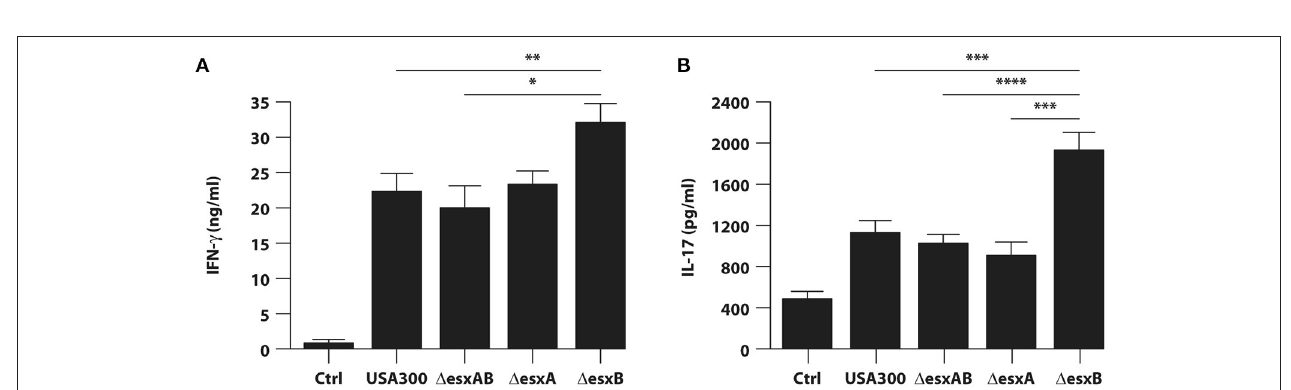
FIGURE 6 | Expansion of IFN- γ or IL-17 producing T cells by cytokine milieu released from DC infected with wild type USA300 and esx mutants. Total CD4 + T cells were stimulated with anti-CD3/CD28 magnetic beads in presence of supernatants derived from DC cultures untreated or infected for 24 h with wild type USA300 or esx mutants. IFN- γ (A) and IL-17 (B) production was evaluated in harvested supernatants by ELISA. The results shown represent means ± SEM of 4 independent experiments. Significance was calculated by Student’s t- test. * P = 0.006; ** P = 0.01; *** P = 0.02; **** P = 0.05.